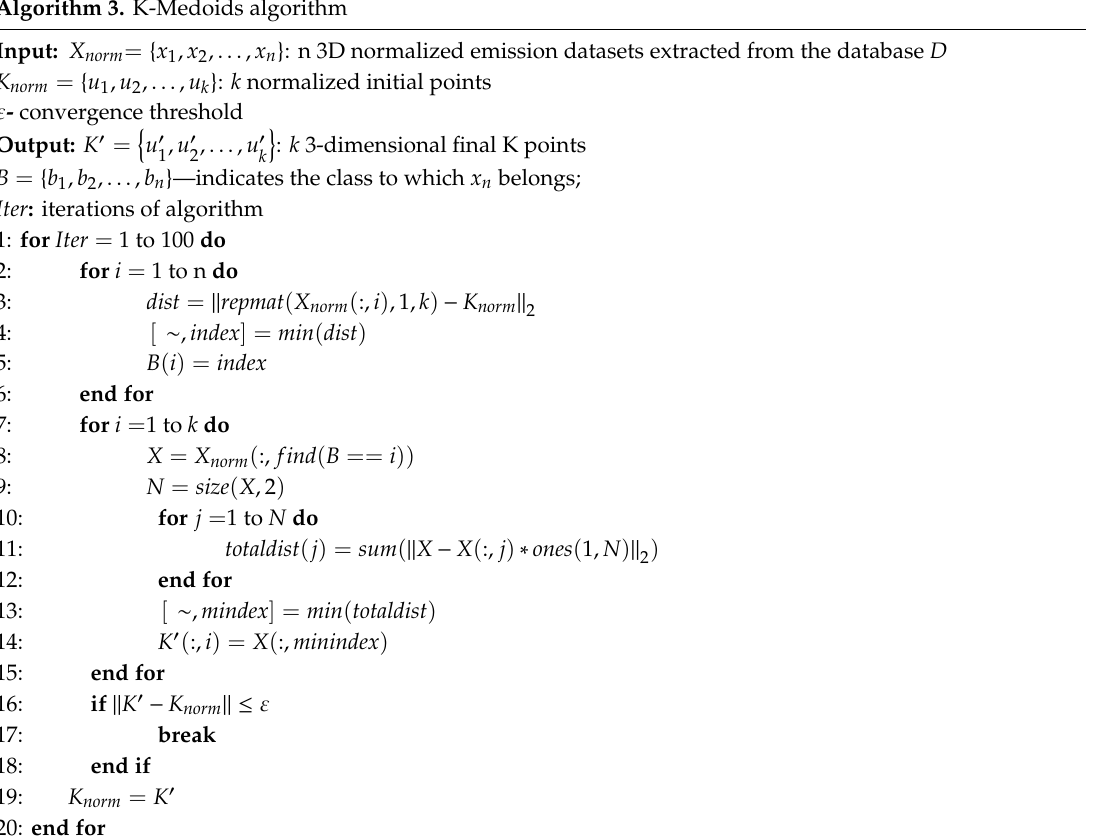
Algorithm 3. K-Medoids algorithm